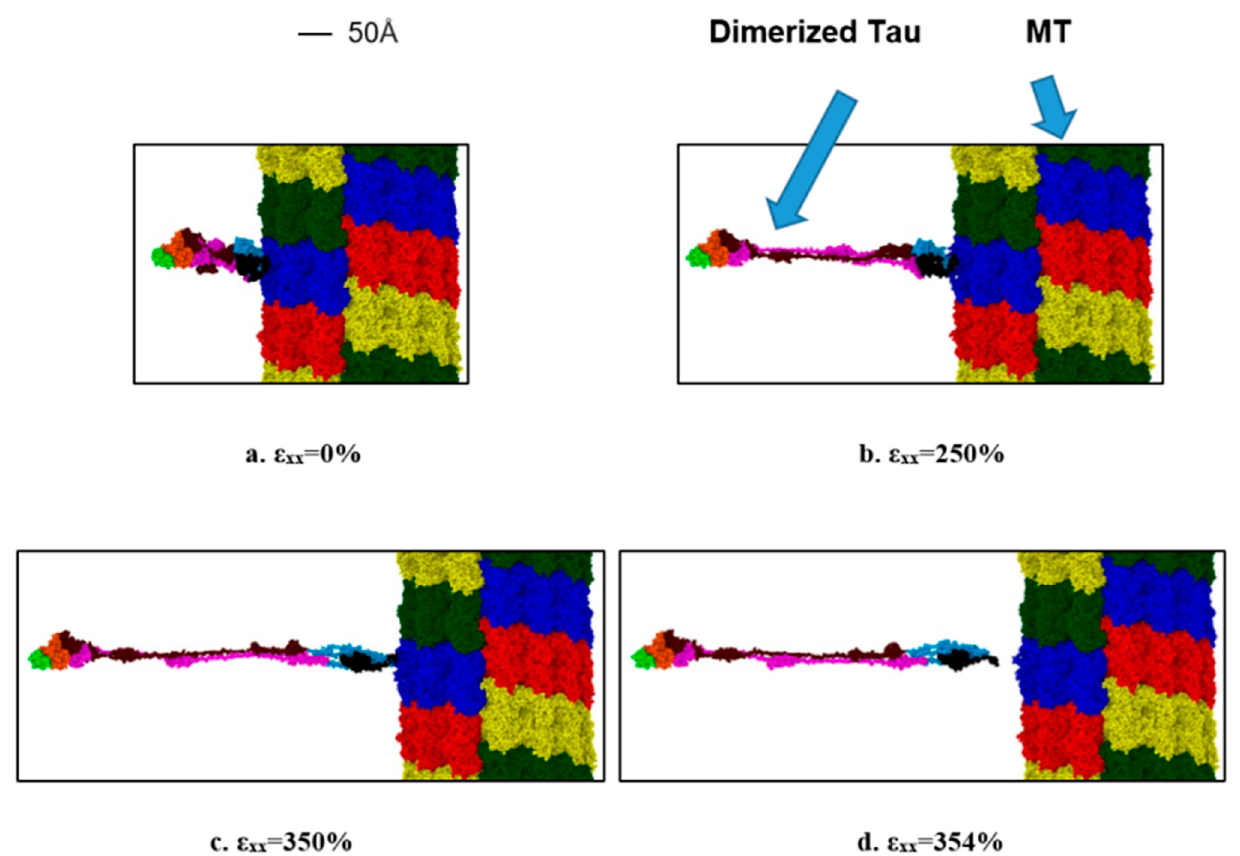
Figure 8. Observation during the dimerized tau pulling away from the MT surface ( − x-direction, strain rate: 2 × 10 9 s − 1 ). ( a ) Initial stage (strain: 0%), ( b ) unfolding and stretching of tau (strain: 250%), ( c ) onset of separation (strain: 350%), ( d ) after separation (strain: ~354%). Color legends: Red, blue, green, and yellow: repeating helical units of MT, maroon: projection domain of tau 1, orange: MT binding site atoms of tau 1(including the inter-repeats), light green: tail domain of tau 1, purple: projection domain of tau 2, light blue: MT binding site atoms of tau 2 (including the inter-repeats), black: tail domain of tau 2.